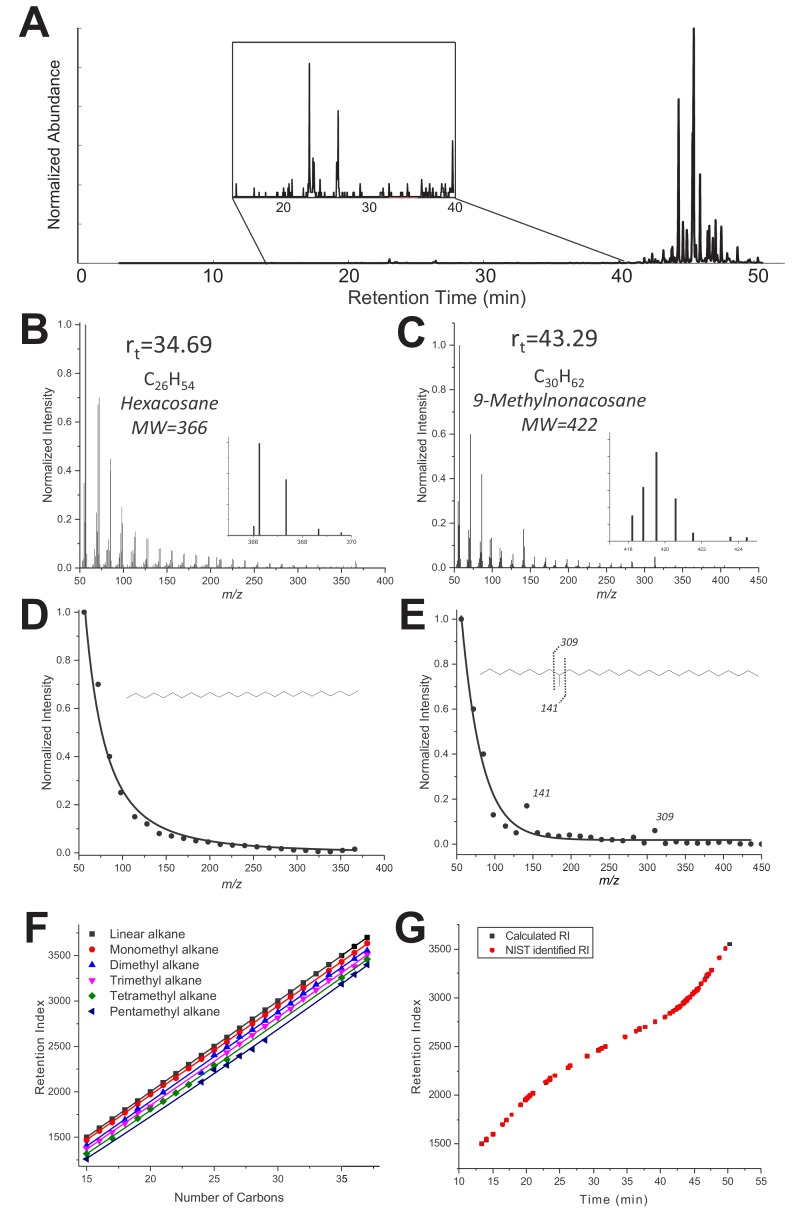
(A) Typical GC-MS chromatogram of a TF sample from C. floridanus, showing the main hydrocarbons C28-C37 eluting after 40 min. The insert shows the region with minor hydrocarbons and other components C15-C28. (B–C) GC-MS Mass spectra of a linear alkane (C26, elution time 34.69 min, panel B) and a methylated alkane (C30, Rt 43.29 min, panel C). (D-E) Extracted MS spectra were fitted with an exponential decay equation with their proposed structure based on enhanced fragment ions (m/z 141 and 309 in the case of 9-methylnonacosane). (F) RI values vs. number of carbons extracted from the NIST Chemistry WebBook library, depending on the number of methyl branches: linear (black), monomethyl (red), dimethyl (blue), trimethyl (pink), tetramethyl (green) and pentamethyl (dark blue) alkanes. (G) Retention index values calculated for each compound listed in Table 1 are based on the elution time and RIs of a hydrocarbon ladder from C8-C40 (black) overlaid with NIST RI values reported in the NIST database for the identified hydrocarbons (red).